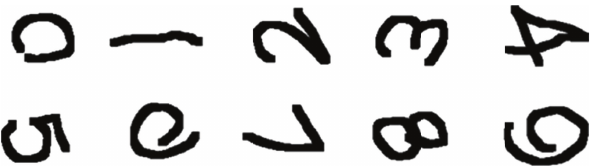
Figure 10: ISAC robot.